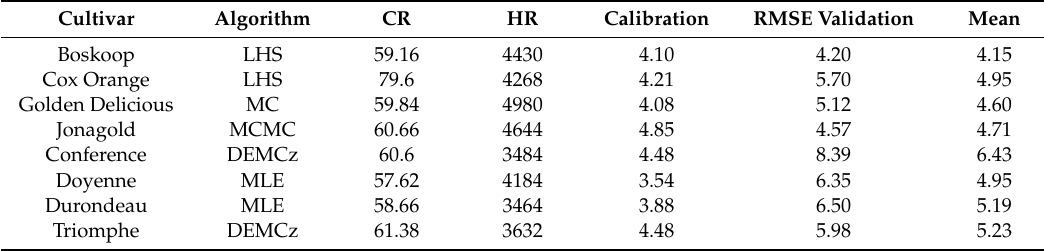
Table A2. Parameters from optimisations with the lowest RMSE, dynamic + GDH model. The RMSE values are given separately for the calibration and validation sets. The mean column gives the mean of both